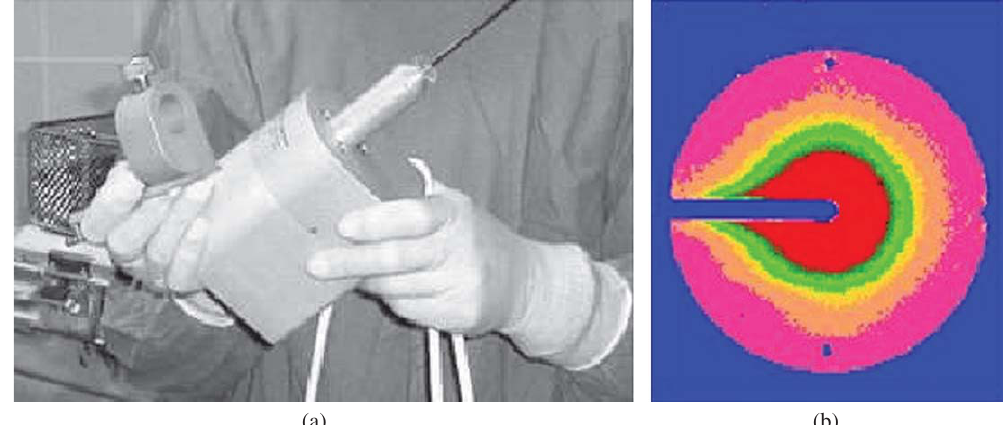
Fig. 2. PRS Photon Radiosurgery System (by Carl Zeiss ® . a) The X-ray source (PRS 400) at the Neurosurgical Department, University of Florence, Italy. b) The PRS radiation dose distribution is nearly spherical.